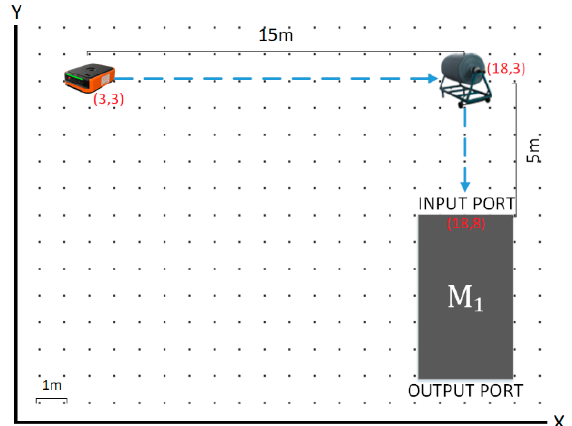
Figure 6. Path planning with instant position tracking in an environment of 20 × 14 m 2 .